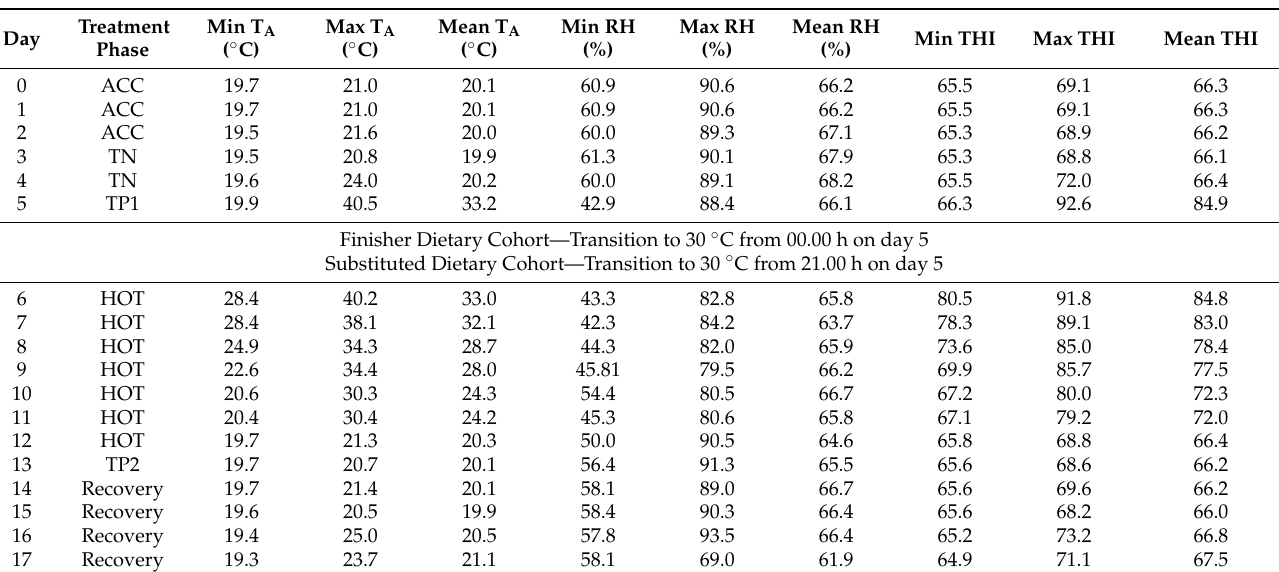
Table 1. The ambient temperature, relative humidity and temperature humidity index for finisher and substituted diet cohorts of cattle when in the climate control